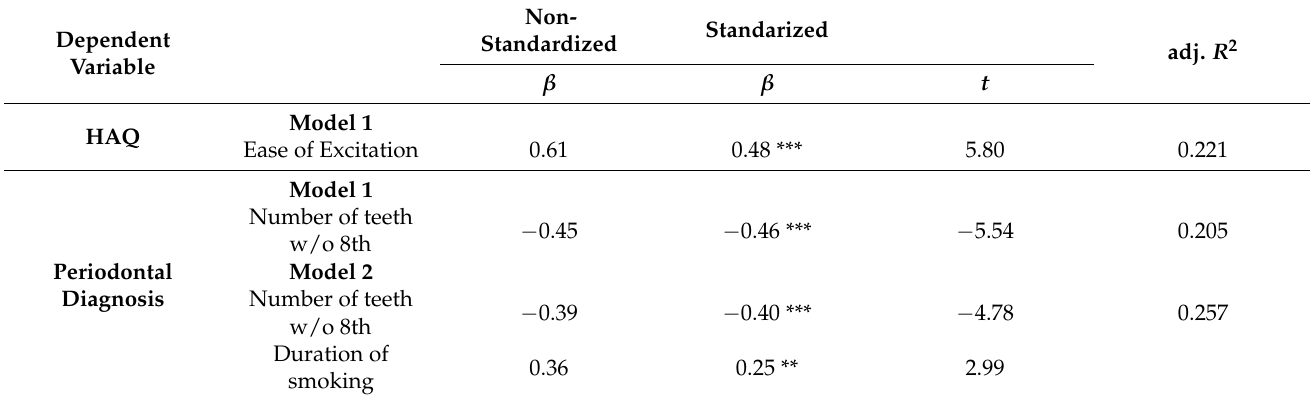
Table 5. Regression analysis for predicting dental anxiety and periodontal diagnosis ( n = 116). Non- Standardized